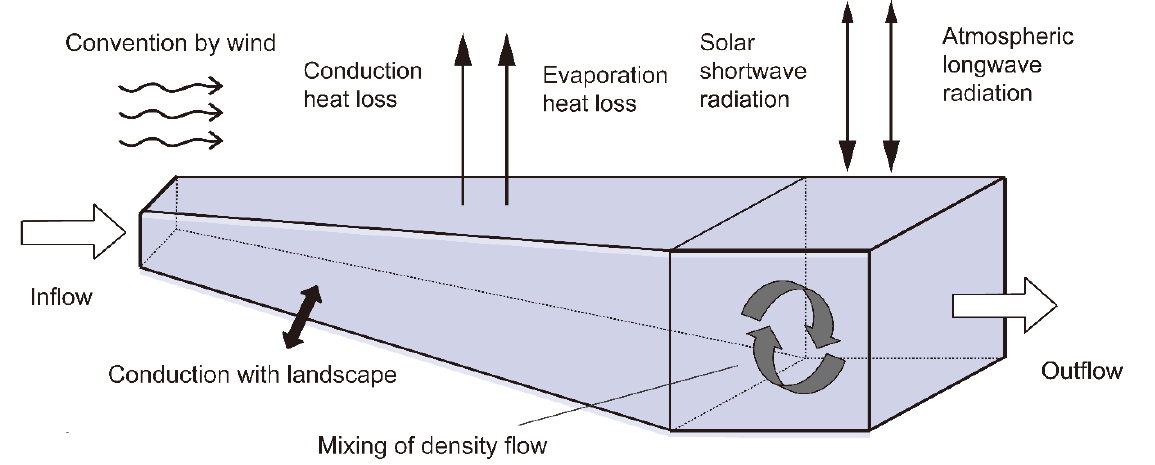
Figure 4. The heat exchange in a reservoir.